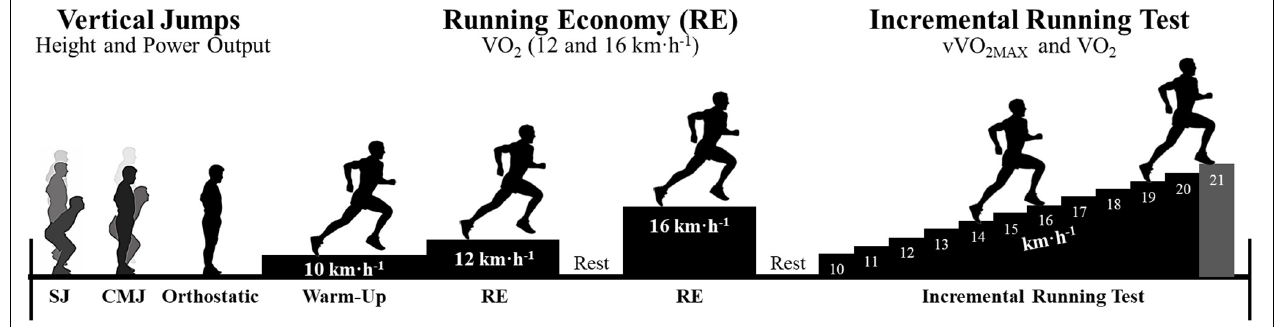
FIGURE 1 | Experimental